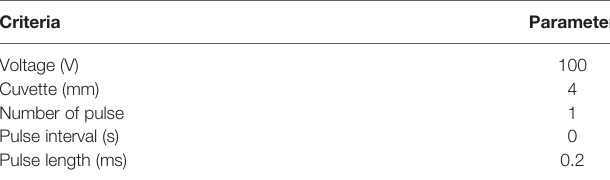
TABLE 3 | The electroporation parameters for Cfap206 -dsRNA delivery. Criteria